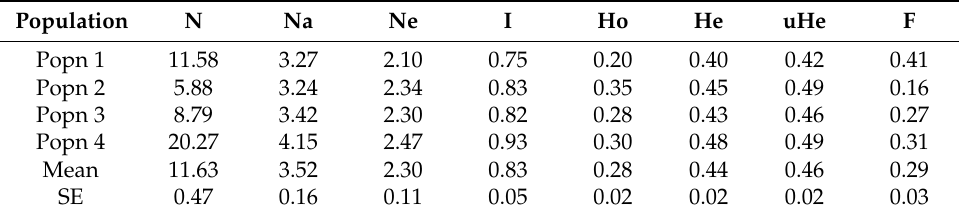
Table 4. Summary of di ff erent C. cajan population diversity statistics averaged over the 35 SSR loci.